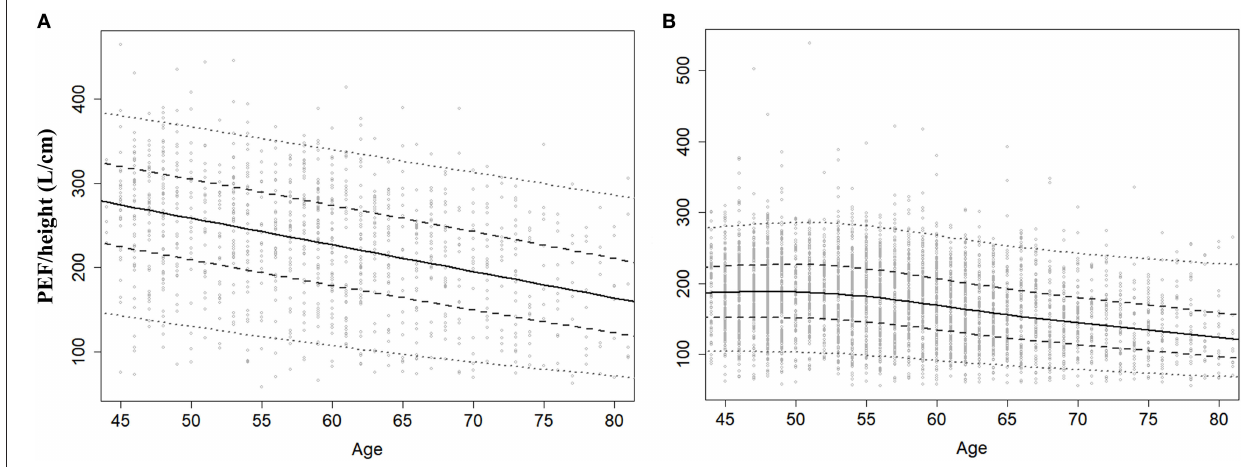
FIGURE 2 | Centiles curve for standardized PEF men (A) and women (B) . Centiles were estimated by Lambda–Mu–Sigma (LMS) method.